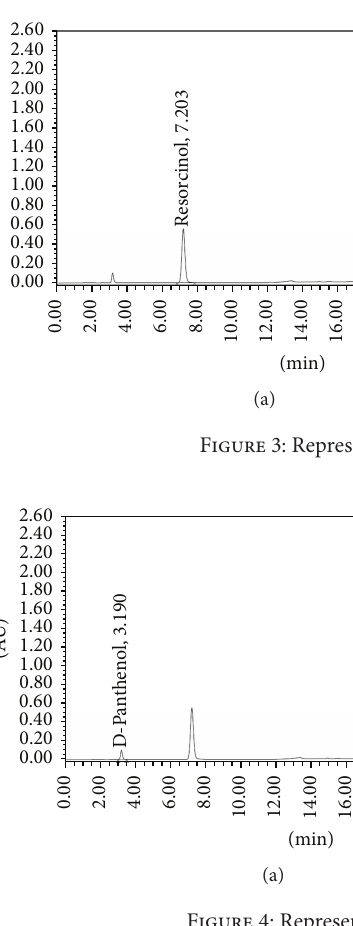
Figure 4: Representative chromatogram for dexpanthenol standard (a) and sample